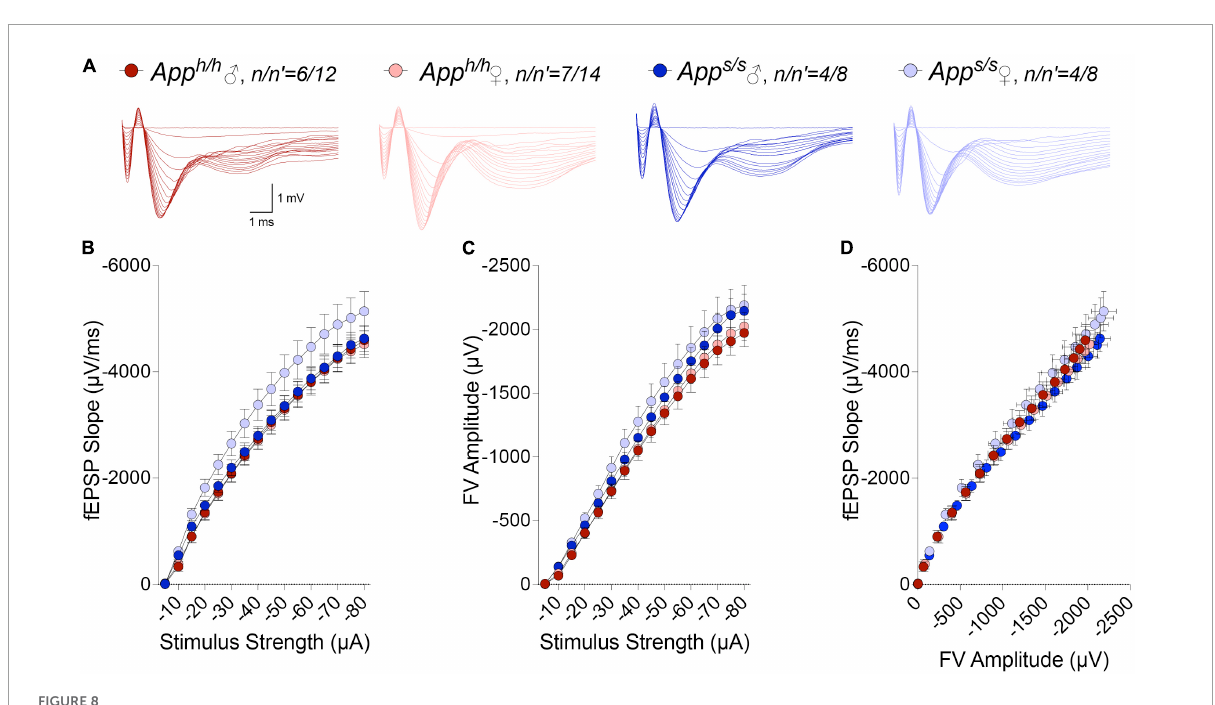
FIGURE8 I/O responses analysis in App h / h and App s / s rats. (A) Representative traces of fEPSP in response to increasing stimulus from -5 to -80 µ A. (B) I-O curve generated from the slope fEPSP versus stimulus strength (2-way ANOVA summary, F ( 3 , 38 ) = 1.710; p = 0.1813). (C) I-O curve generated from FV amplitude versus stimulus strength (2-way ANOVA summary, F ( 3 , 38 ) = 1.262, p = 0.3010). (D) I-O curve generated from the slope fEPSP versus FV amplitude. Data are represented as mean ± SEM. Data were analyzed by two-way ANOVA for repeated measures followed by post-hoc Tukey’s multiple comparisons test when ANOVA showed statistically significant differences. n = number of animals; n (cid:48) = number of